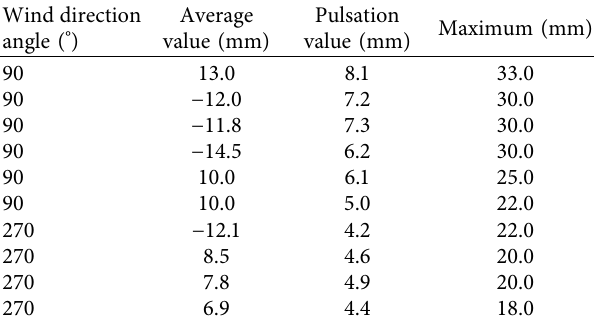
Table 4: The maximum expansion of the type 2